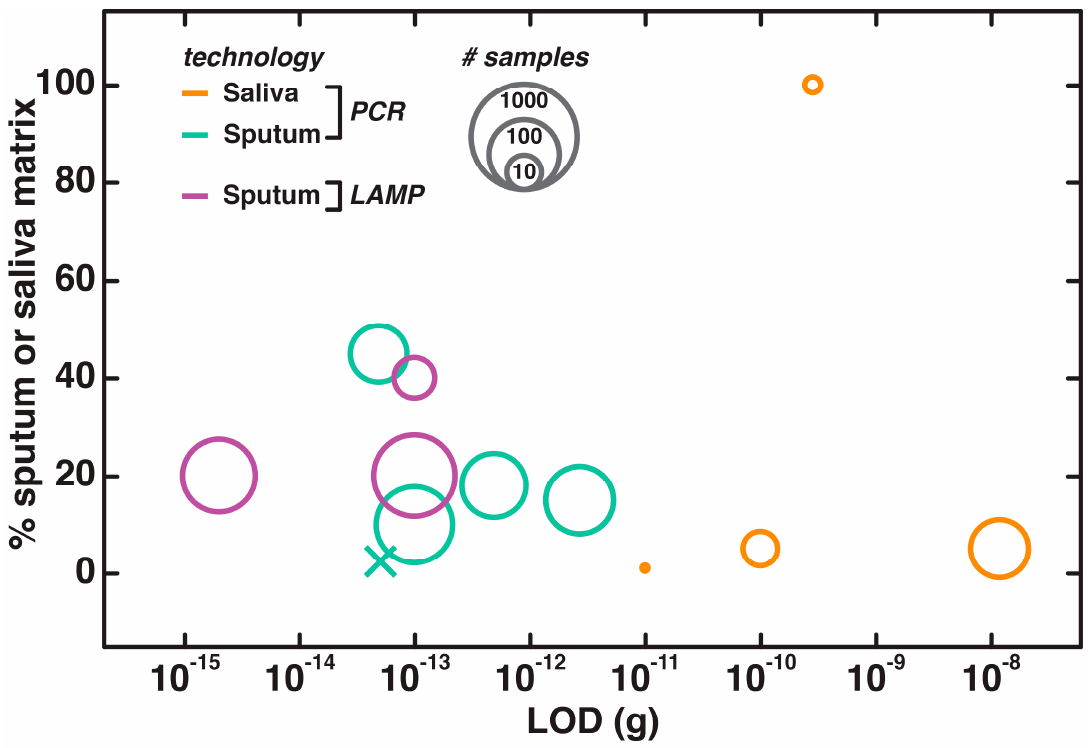
Figure 6. Nucleic acid testing procedures in saliva and sputum, with data presented as in Figure 3.